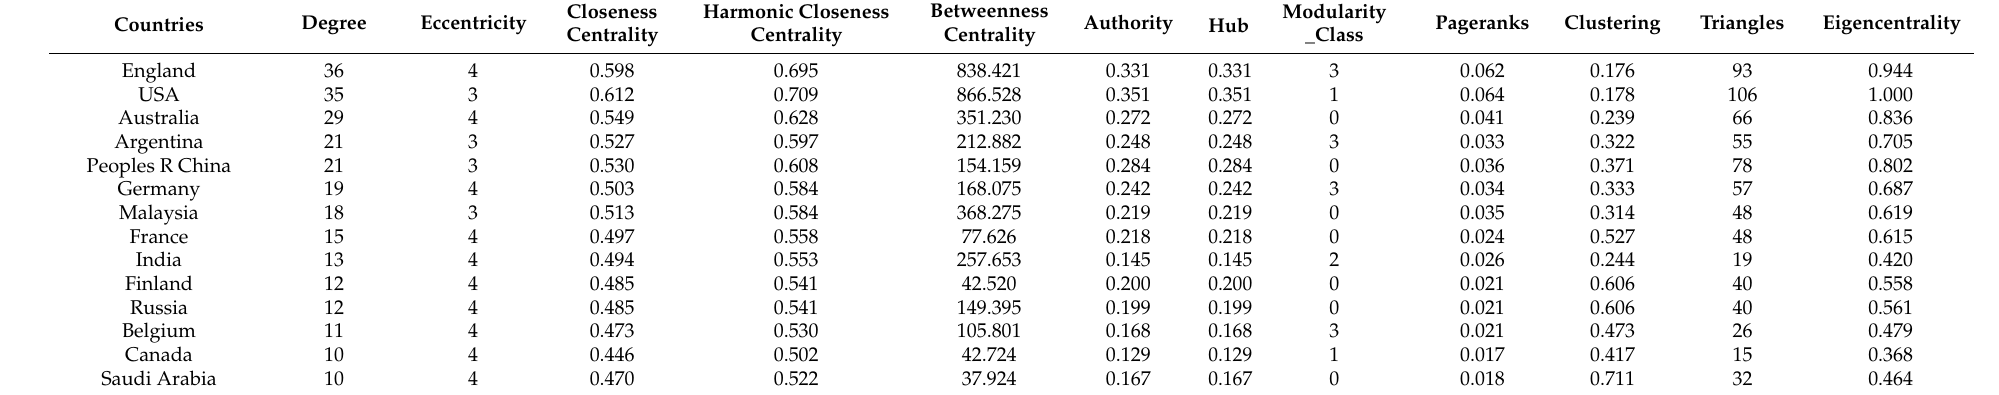
Table 8. Network, node, and edge statistics for co-authorship links and top 15 (degree) countries items, considering 1 as the minimum number of documents of a country.